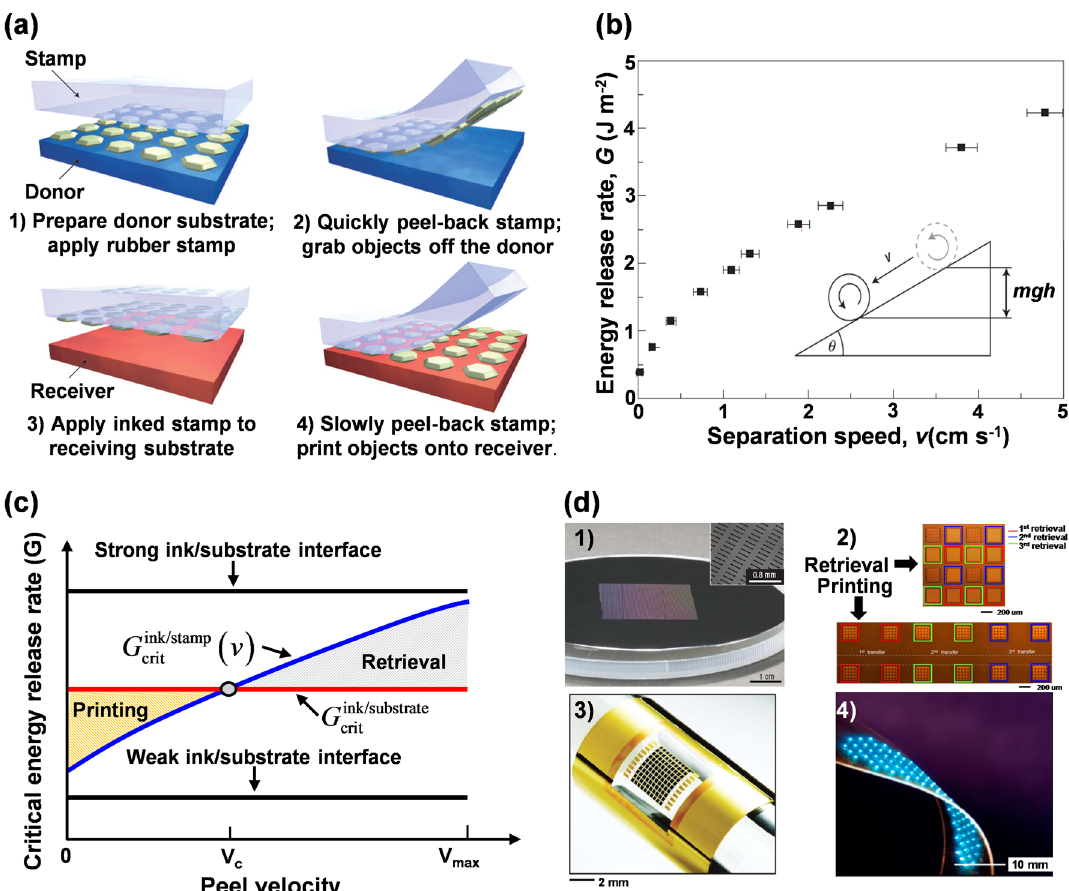
Fig. 4 Kinetically controlled transfer printing technique. a Schematic illustration of the transfer printing process: retrieval at high velocity and printing at low velocity. Reprinted with permissions from ref. 48 b Rate dependency of the critical energy release rate obtained by rolling down a steel cylinder on an inclined PDMS slab. Reprinted with permissions from ref. 48 c The criterion for kinetically controlled transfer printing. Adapted with permission from ref. 53 d Structures, electronics and optoelectronics enabled by kinetically controlled transfer printing technique. ( 1 ) Large scale (30 mm × 38 mm) array of I-shaped silicon microstructures printed in ambient conditions directly onto a 100 mm GaAs wafer in a parallel way. Reprinted with permissions from ref. 48 ( 2 ) Selective retrieval and non-selective printing in three sequences with area expansion of inorganic LEDs. Adapted with permission from ref. 20 ( 3 ) Bendable GaAs solar cells arrays. Reprinted with permissions from ref. 70 ( 4 ) GaN LED arrays printed on a plastic substrate. Reprinted with permissions from ref.